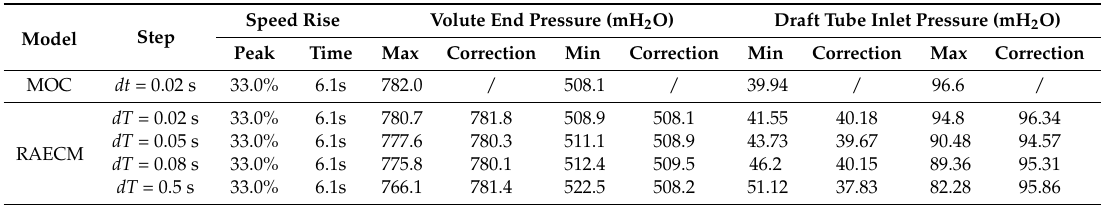
Table 1. Comparison between RAECM with variable space-step discretization and MOC.